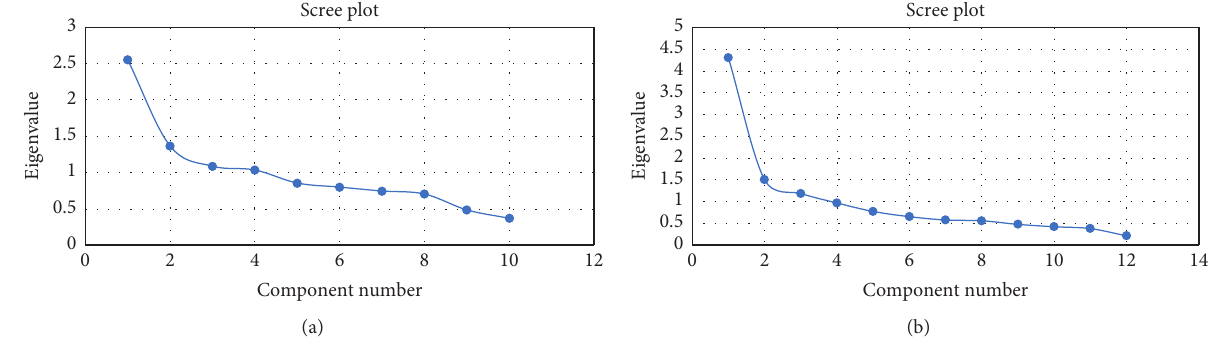
Figure 5: The scree plots of the onboard activities (a) and the tools carried by travelers (b). Table 21: Rotated component matrix a